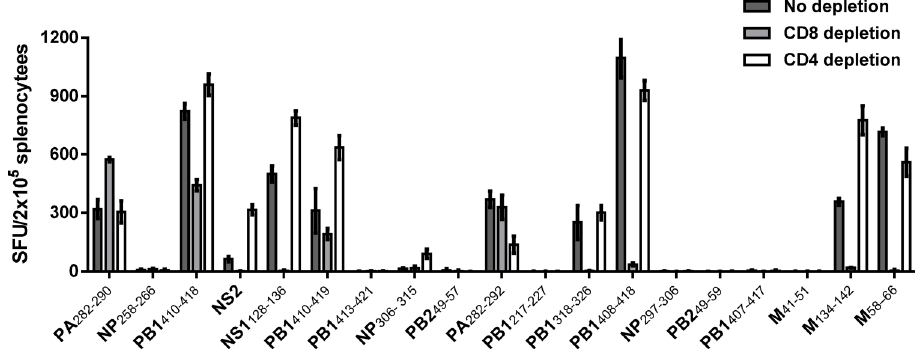
Fig 1. Induction of double restricted responses after peptide immunization of HLA transgenic mice. Eighteen groups of 3 – 5 mice were injected intraperitoneally three times at two week intervals with CAF09 plus one of the 9-11mer peptides (20nM). One week after the last immunization, IFN γ ELISpot was used to measure HLA-A * 02:01 and/or HLA-DRB1 * 01:01 restricted CD8 and CD4 T cell responses. As a control, a group of mice (n = 4) was injected intraperitoneally three times at two week intervals with CAF09 plus the known HLA-A * 02:01 binding peptide M(58 – 66) (21). Each bar represents mean ± SD of IFN γ spot forming units (SFU) of groups of 3 – 5 immunized mice from which splenocytes were pooled and depleted for CD4 or CD8 positive cells before being stimulated ex vivo with peptide in four replicate cultures. Experiments were conducted 1 – 5 times depending on the individual